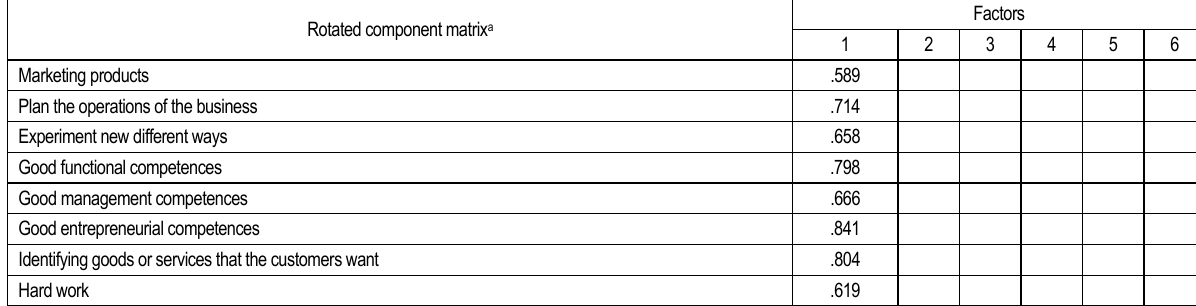
Table 6. Factor loadings of correlation coefficient based on Varimax rotation of factors